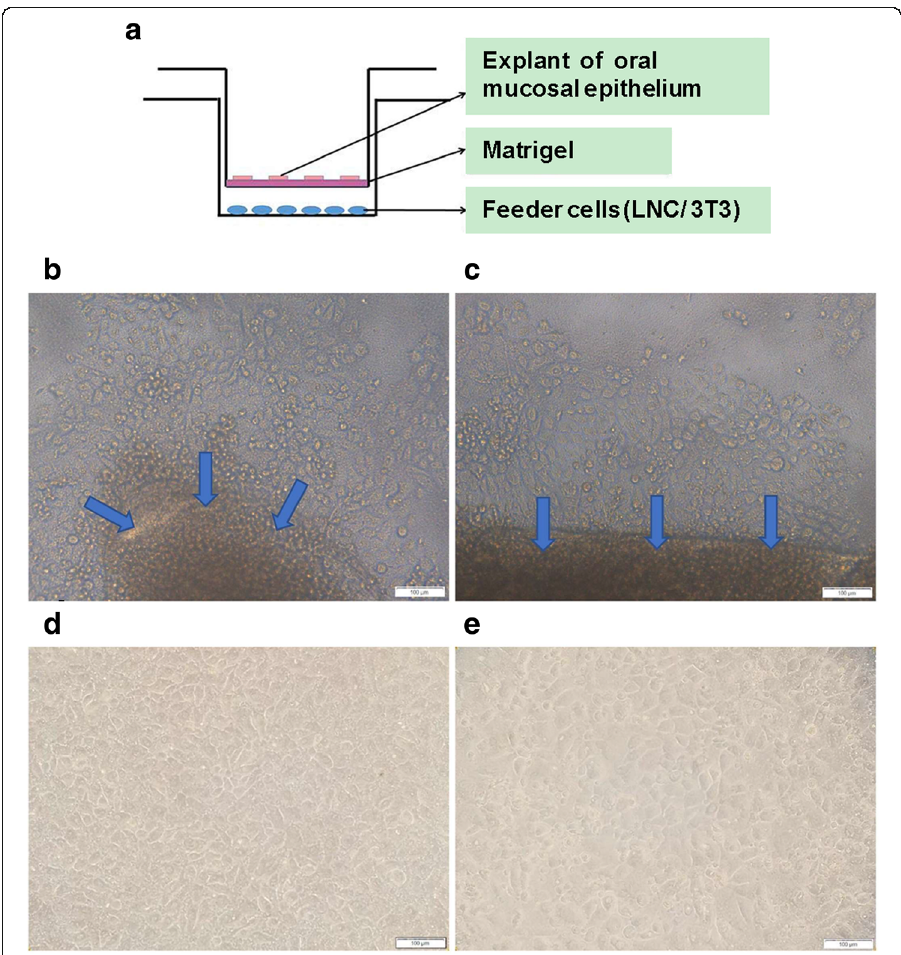
Fig. 1 Morphological appearance of cultivated oral mucosal epithelial cells (COMECs) co-cultured with different feeder layers. a Schematic illustration of the culture model. COMECs co-cultured with LNCs ( b, d ) or 3T3 cells ( c, e ). Epithelial cells migrated from the periphery of oral explants (blue arrows) on day 3 ( b, c ). A 90 – 100% confluent monolayer could be reached on day 9 ( d, e ). LNCs: limbal niche cells, scale bars: 100 μ